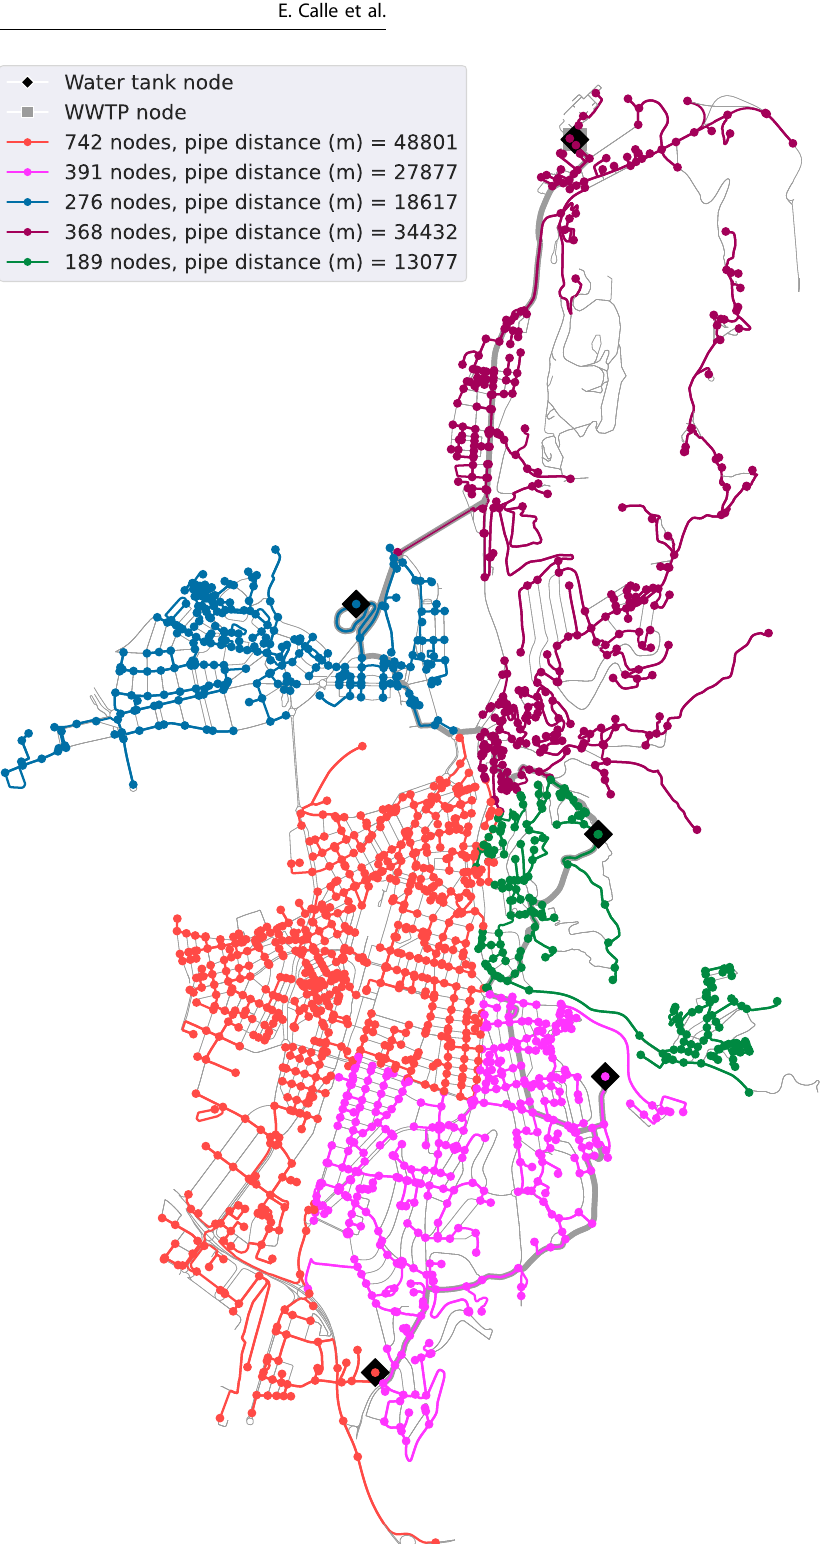
Fig. 3 Reclaimed water network visualization (Girona). The reclaimed water network for the case study of Girona is illustrated with fi ve clusters and for both public and private uses. The city street graph is represented in gray paths and the generated branched networks in different colors (for each cluster). Black rhombuses indicate the location of water tanks (origin point of a branched network). The main network is represented in wider gray